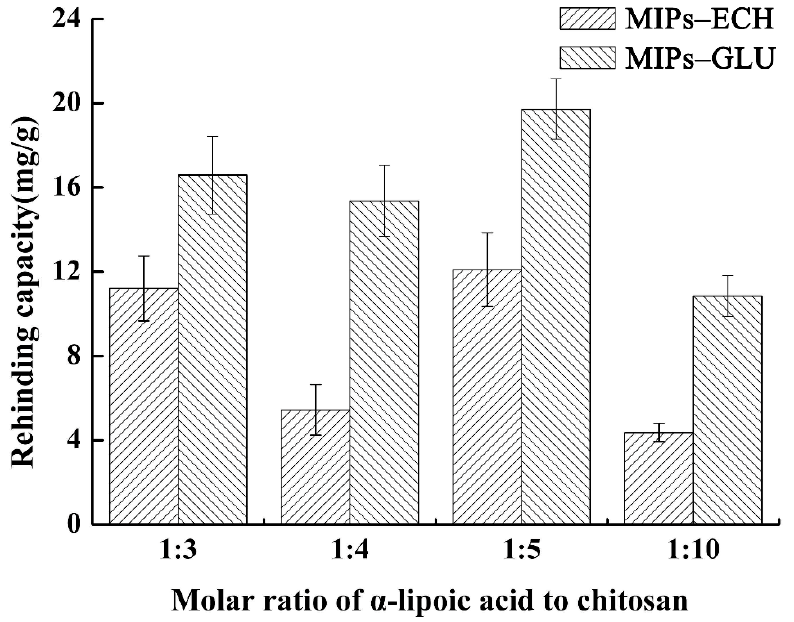
Figure 1. E ff ect of di ff erent molar ratio of alpha-lipoic acid (ALA) to chitosan on the rebinding e ffi ciency Figure 1. Effect of different molar ratio of alpha-lipoic acid (ALA) to chitosan on the rebinding of molecularly imprinted polymers efficiency of molecularly imprinted polymers (MIPs).